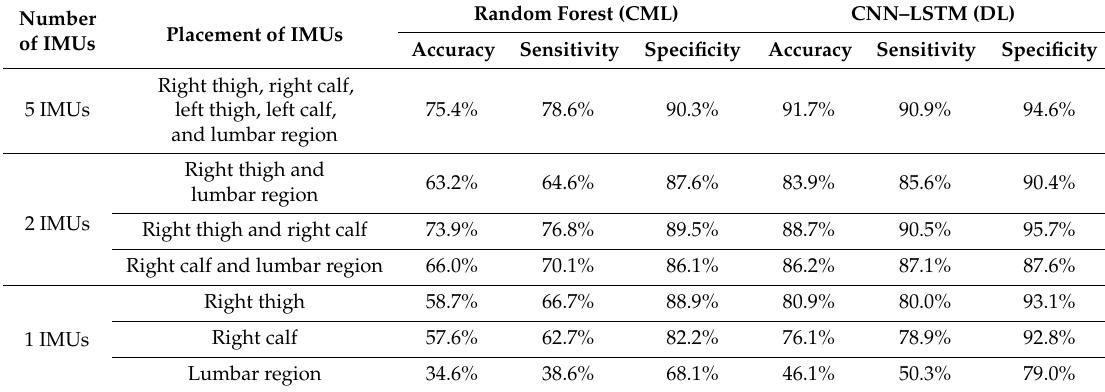
Table 2. Squat classification performance of conventional machine learning (CML) and deep learning (DL) for five IMUs, two IMUs, and one